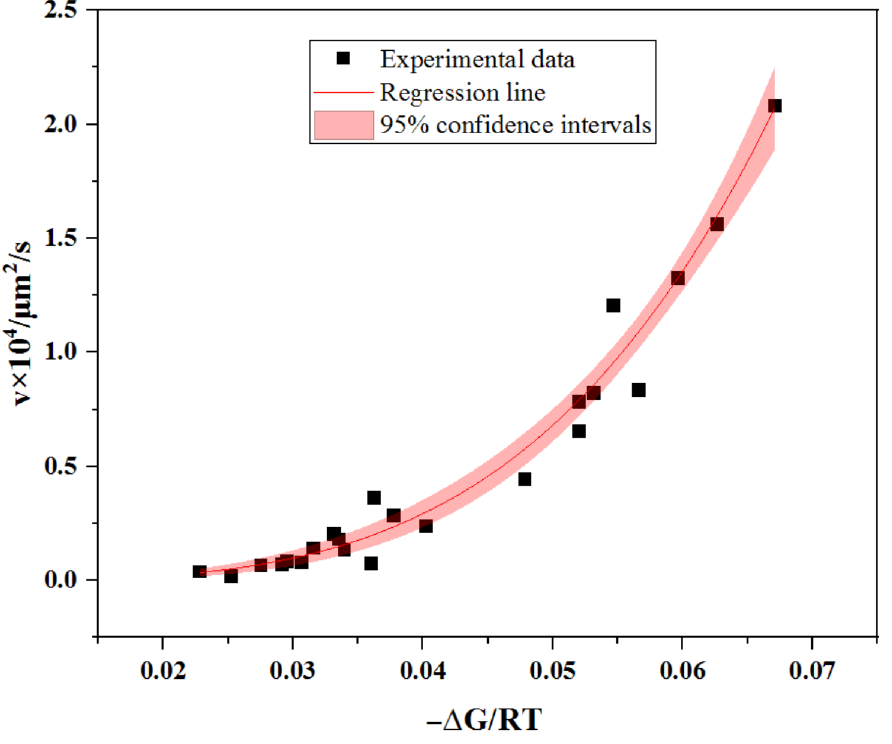
∆ ∆ G/RT). Figure 6. Lateral film growth rates for various Gibbs free energy difference ( − −